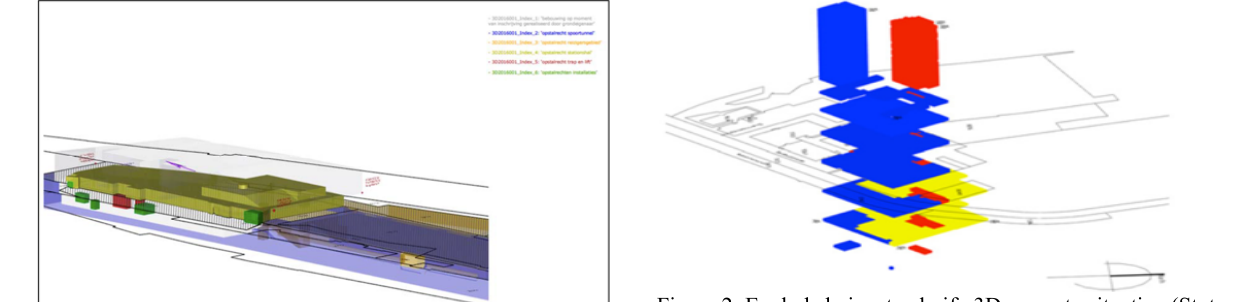
Figure 2: Exploded view to clarify 3D property situation (Stoter et al.,